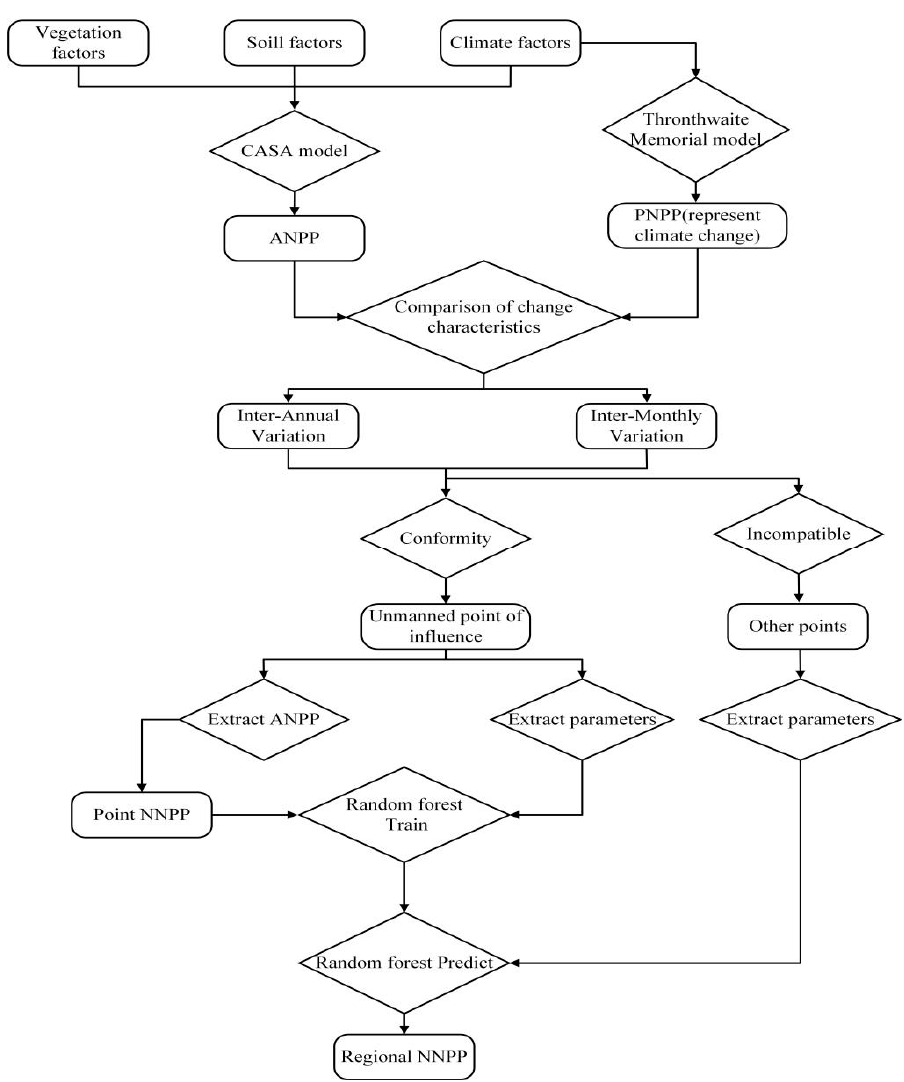
Figure 2. Flowchart of the NNPP.